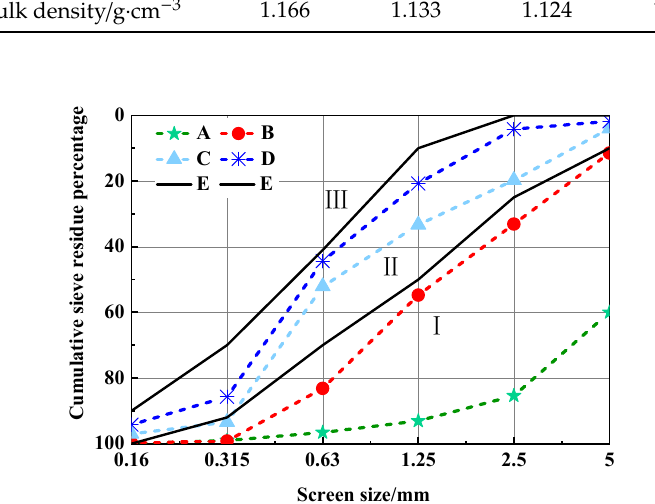
Figure 6. Gradation zone curve of CHPs. (E) Boundary line of the sand in Zone II.